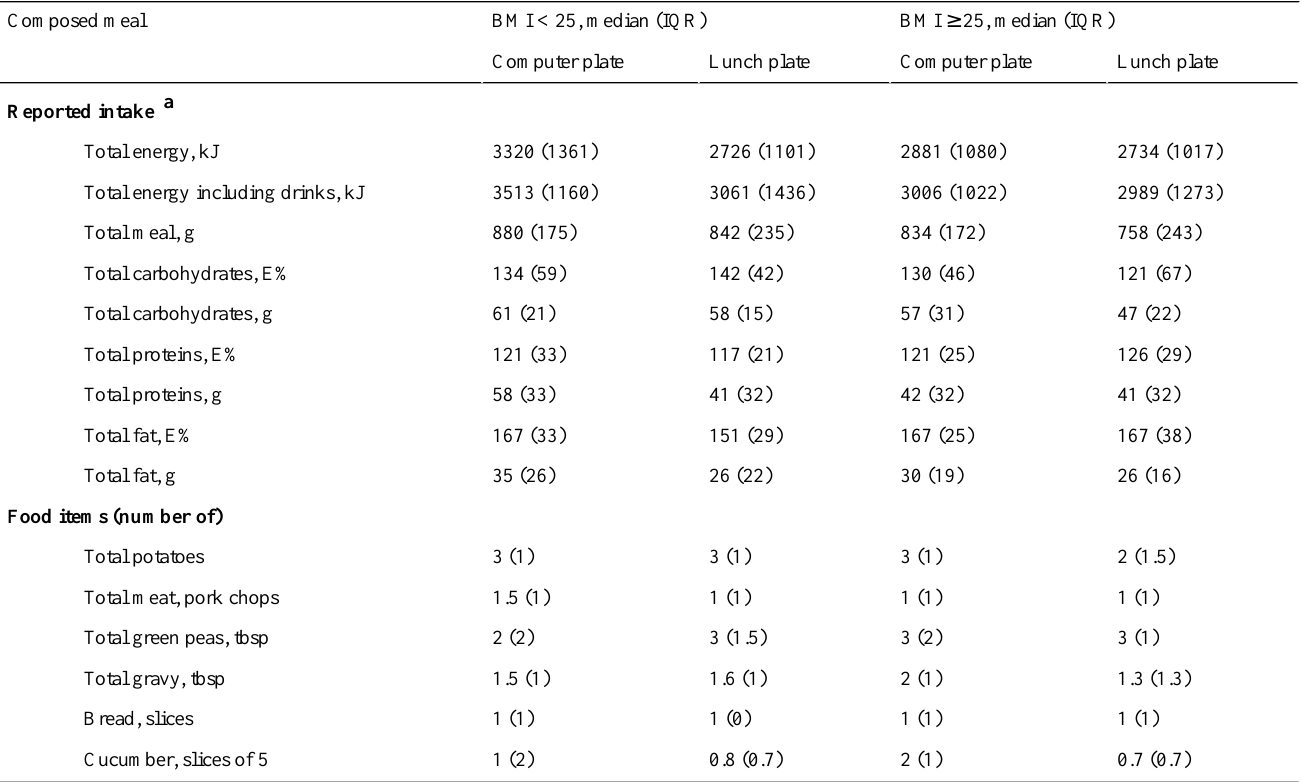
Table 3. Study participants’composed meals using the two meal instruments, by body mass index (BMI)